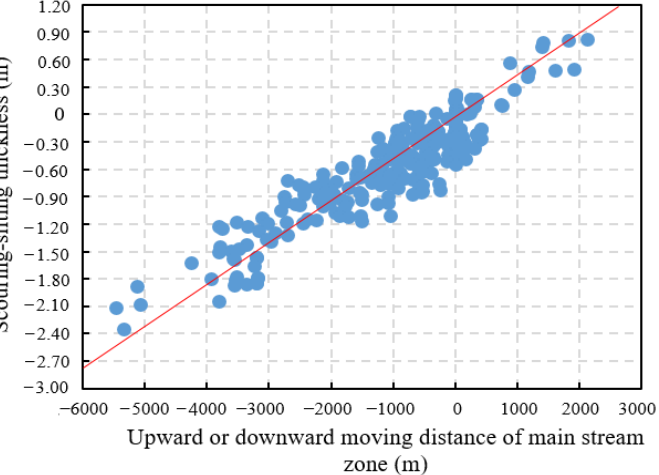
Figure 8. Relationship between the upward or downward moving distance of the main stream zone and the scouring or silting thickness. and the scouring or silting